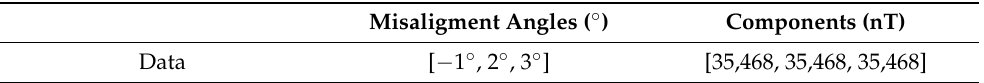
Table 4. Simulation data.